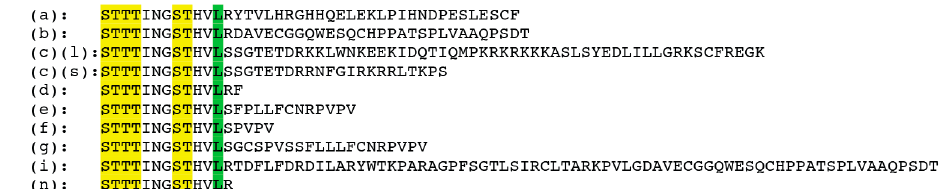
Figure 1. Alignment of C-termini of isoforms found in human tissue: green: leucine 358, the last amino acid common to all variants. For the c isoform, a short and a long one were described. Yellow: S/T cluster necessary for b-arrestin dependent receptor